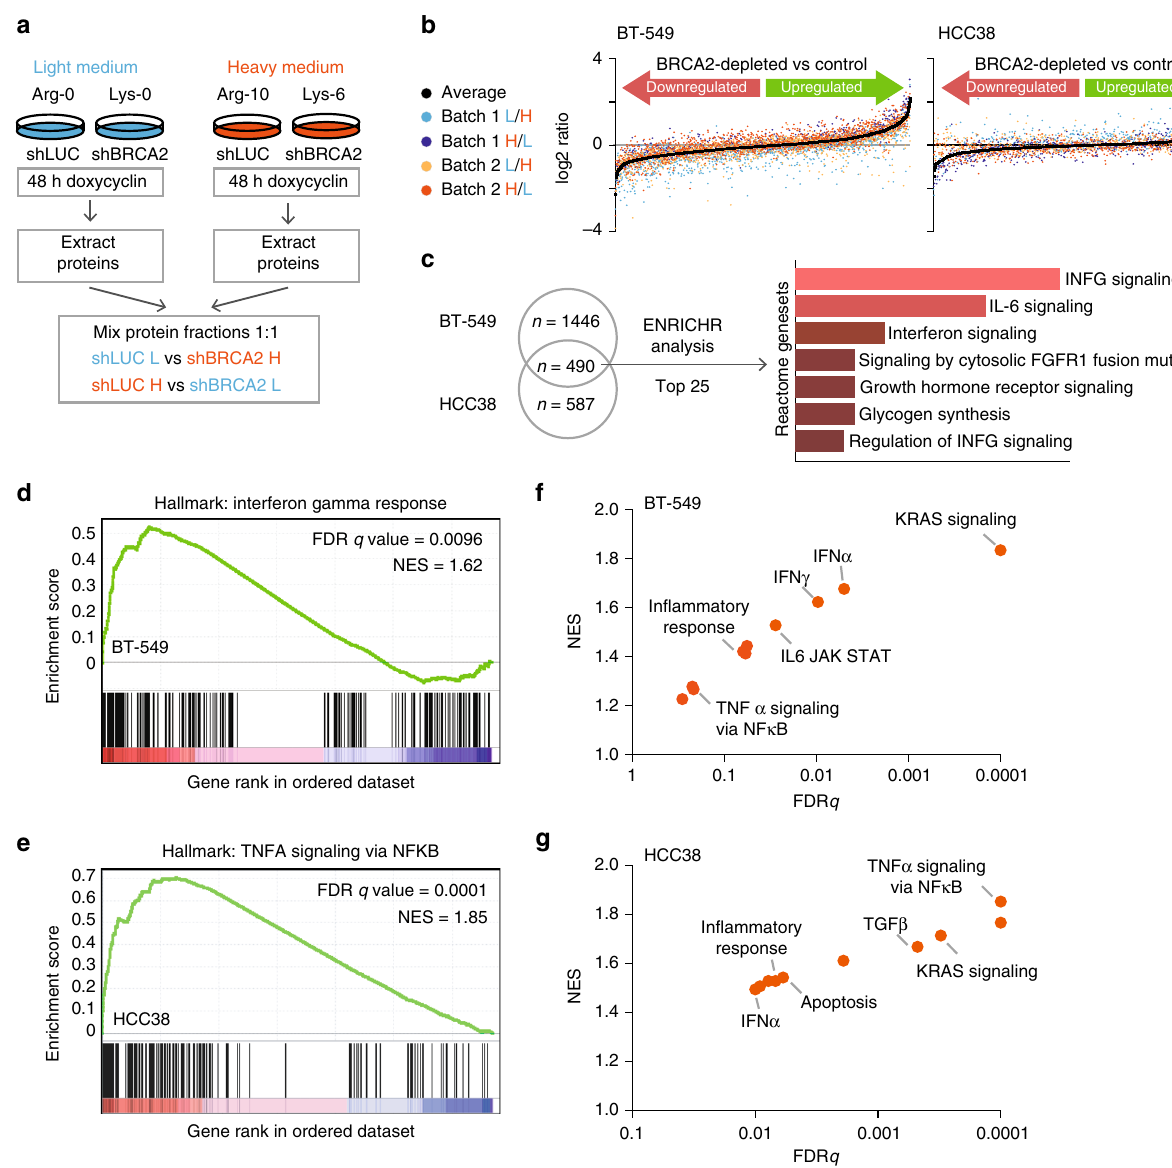
Fig. 5 Proteomic and transcriptomic analysis reveals upregulation of pro-in fl ammatory genes upon BRCA2 depletion. a Work fl ow of SILAC-MS analysis of BT-549 and HCC38 cell lines with indicated shRNAs. b Log2 ratios (heavy vs light) of proteins that were measured in at least three out of four independent MS analyses in BT-549 (left panel) or HCC38 (right panel) cells. Black dots represent the mean of log2 ratios from three or four experiments. c ENRICHR was used to analyze pathway enrichment in top 25 upregulated proteins in response to BRCA2 depletion in BT-549 cells and HCC38 cells. The top 10 enriched Reactome datasets are displayed. d , e RNA sequencing was performed on BT-549 and HCC38 cells harboring shLUC or shBRCA2 #2, treated for 72 h with or without doxycycline. Gene set enrichment analysis (GSEA) using ‘ Hallmark ’ gene sets showed enrichment of Interferon Gamma response ( d ) and TNFA signaling via NF- κ B ( e ) in BRCA2-depleted cells. f , g Top 10 enriched Hallmark gene sets in BRCA2-depleted BT-549 ( f ) and HCC38 ( g ) cells compared to control cell lines. The top 10 list of enriched pathways can be found in Supplementary Fig.